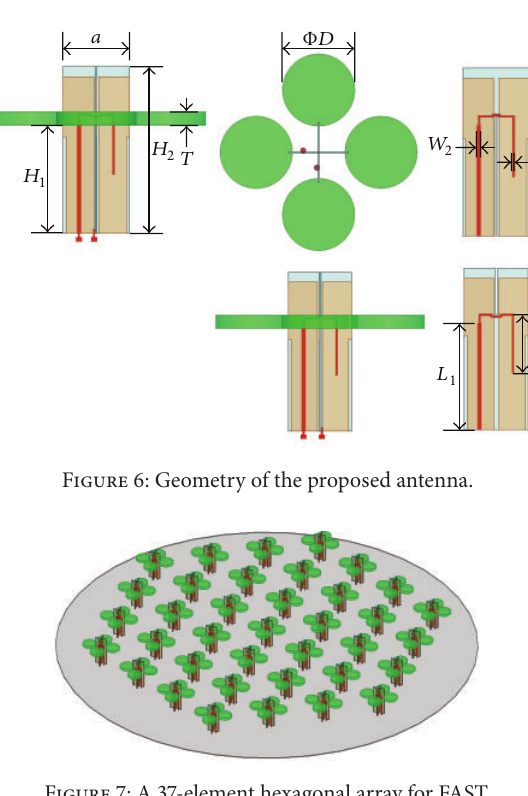
Figure 7: A 37-element hexagonal array for FAST. Table 4: Some parameters of the designed